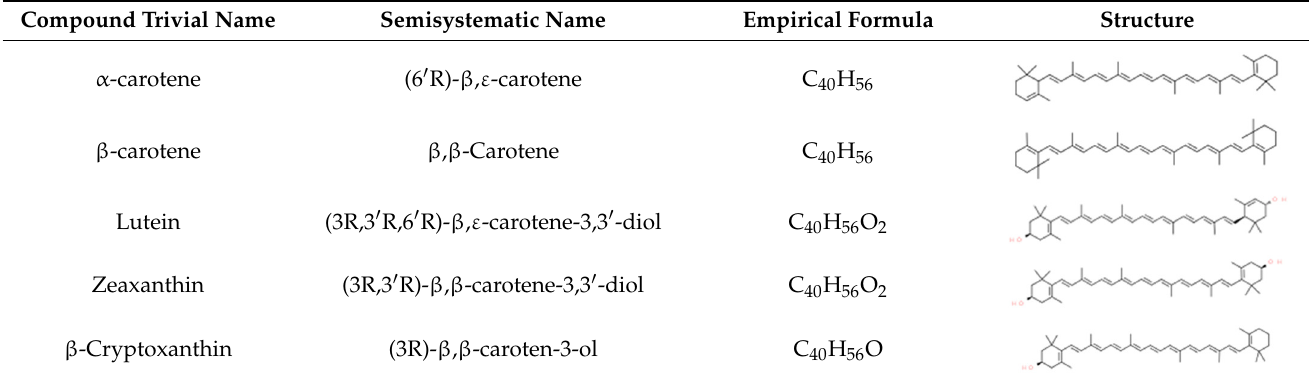
Table 1. Chemical structure of carotenoids found in Cucurbita spp.